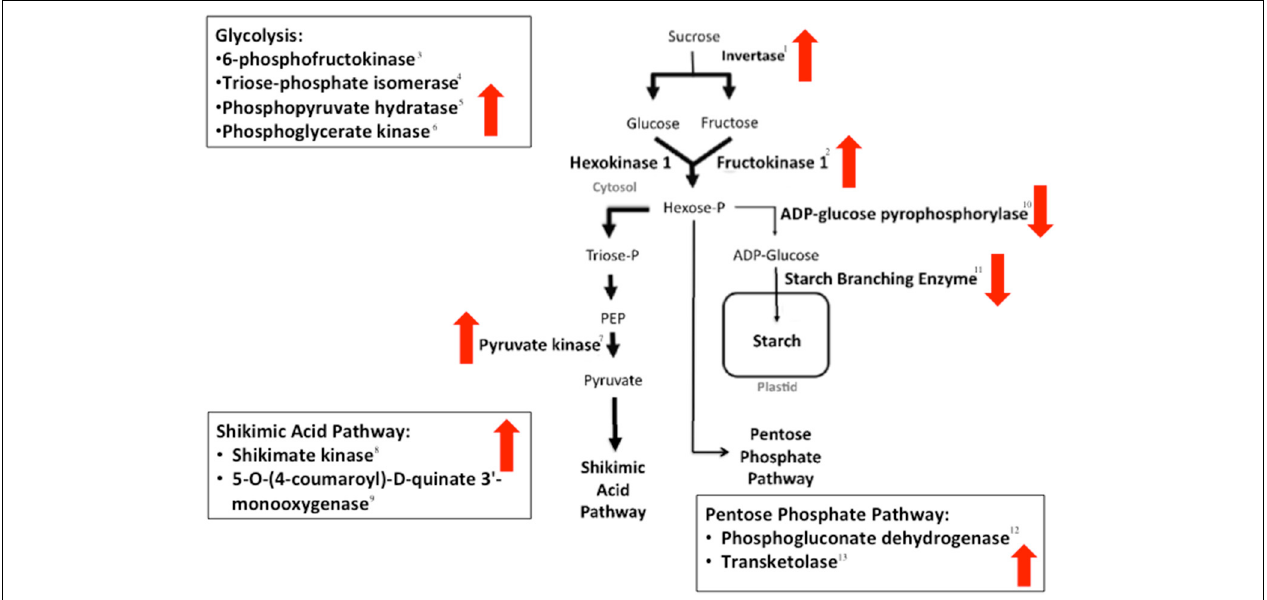
FIGURE 2 | Enzymes in maize seed carbohydrate metabolism whose biosynthetic genes are differentially expressed in the A. flavus -maize interaction. Blackarrowsdenotedescribedcarbohydratemetabolicpathways.